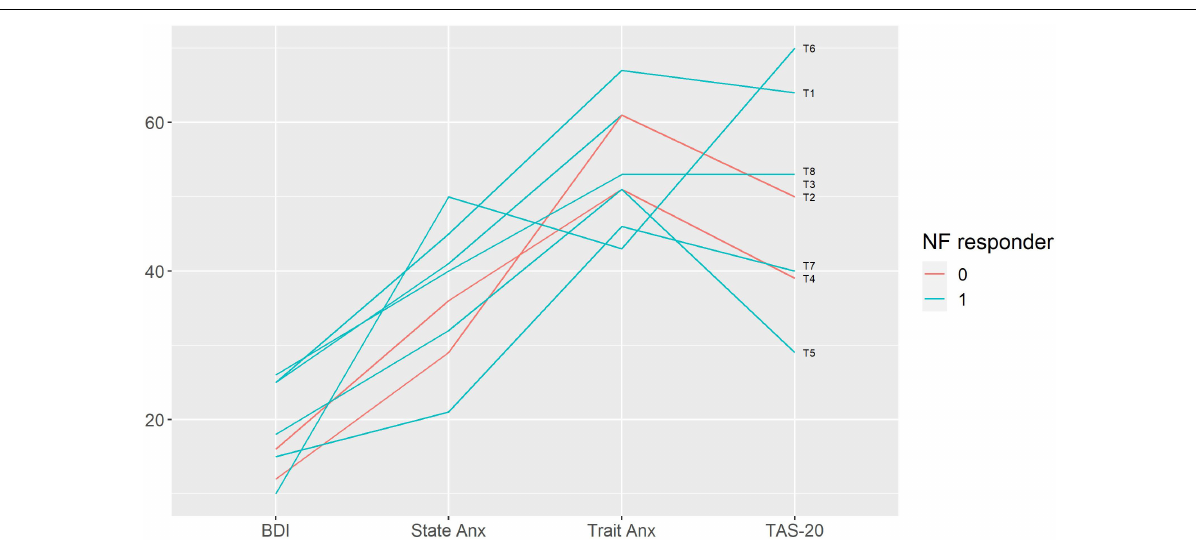
FIGURE 4 | Baseline emotional characteristics in participants with and without response to neurofeedback. Each line represents a patient case (indicated on the right end of the line). Neurofeedback responders are show in blue, neurofeedback non-responders — in red color. BDI — Beck Depression Inventory; State Anx — State Anxiety, Trait Anx — Trait Anxiety (Spielberger State-Trait Anxiety Inventory); TAS-20 — Toronto Alexithymia Scale 20; NF —